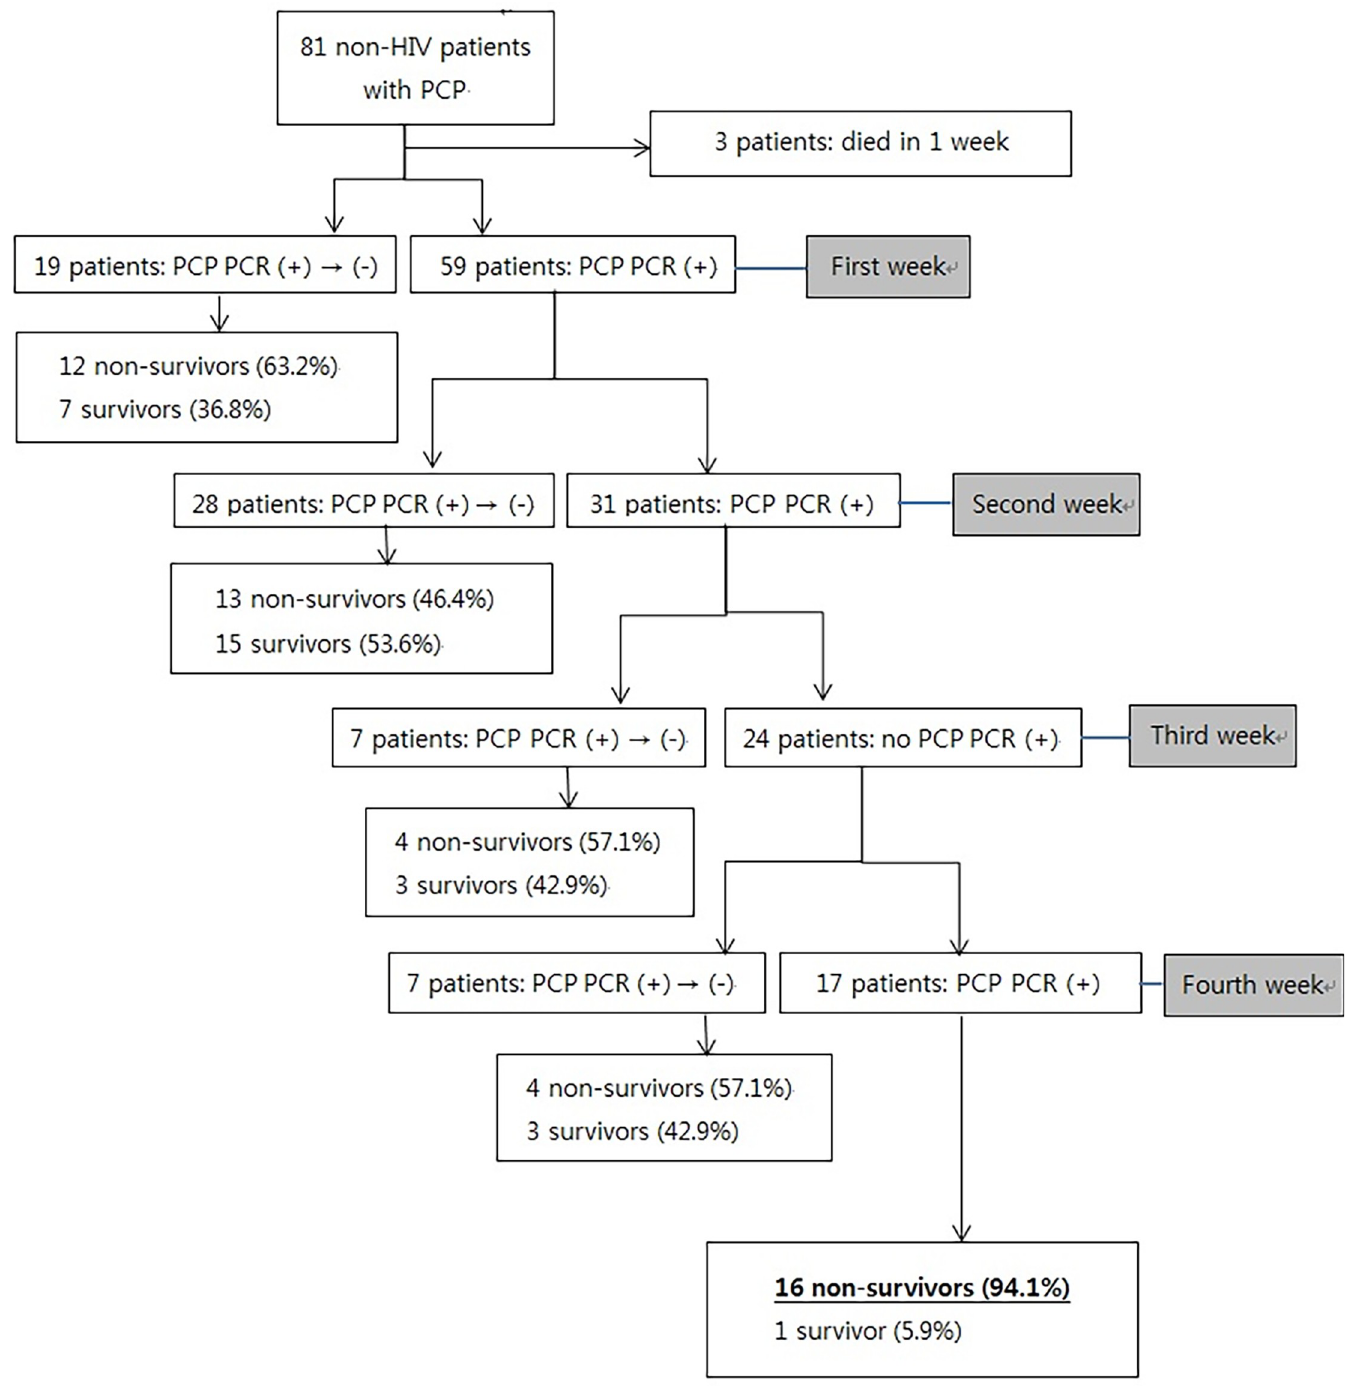
Fig 2. Flowchart showing mortality rates in non-HIV PCP patients with respiratory failure at different times after diagnosis. PCP, jirovecii pneumonia; PCR (+) ! (-), polymerase chain reaction negative conversion; BAL, bronchoalveolar lavage.